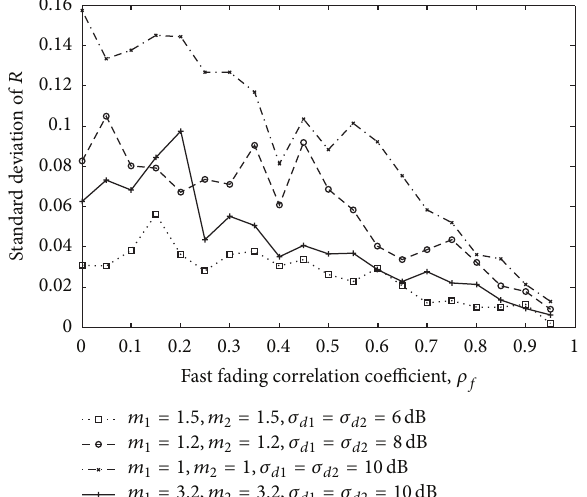
Figure 3: Standard deviation of the sample correlation coefficient as a function of the fast fading correlation coefficient for different parameters of the marginal distributions. The number of obser- vations and number of samples are 𝑁 = 100000 and 𝐾 = 50 , respectively.